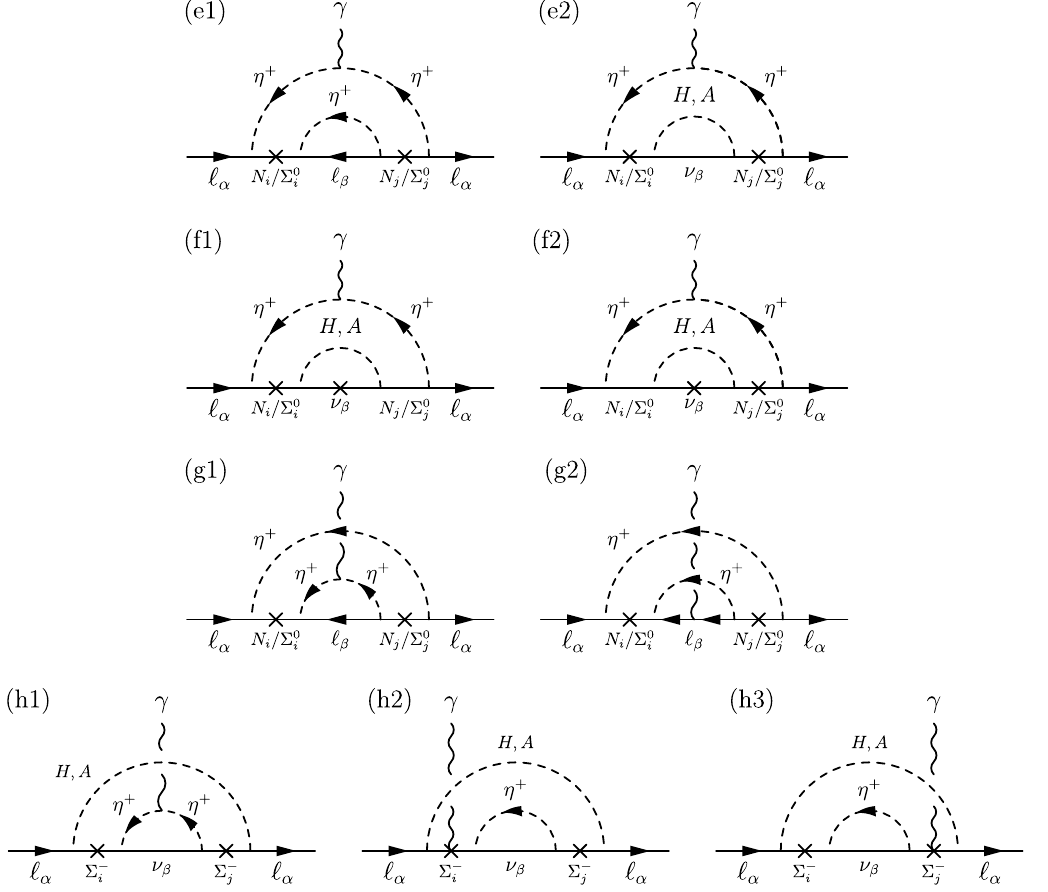
Figure 4 . Majorana type diagrams not contributing to charged lepton